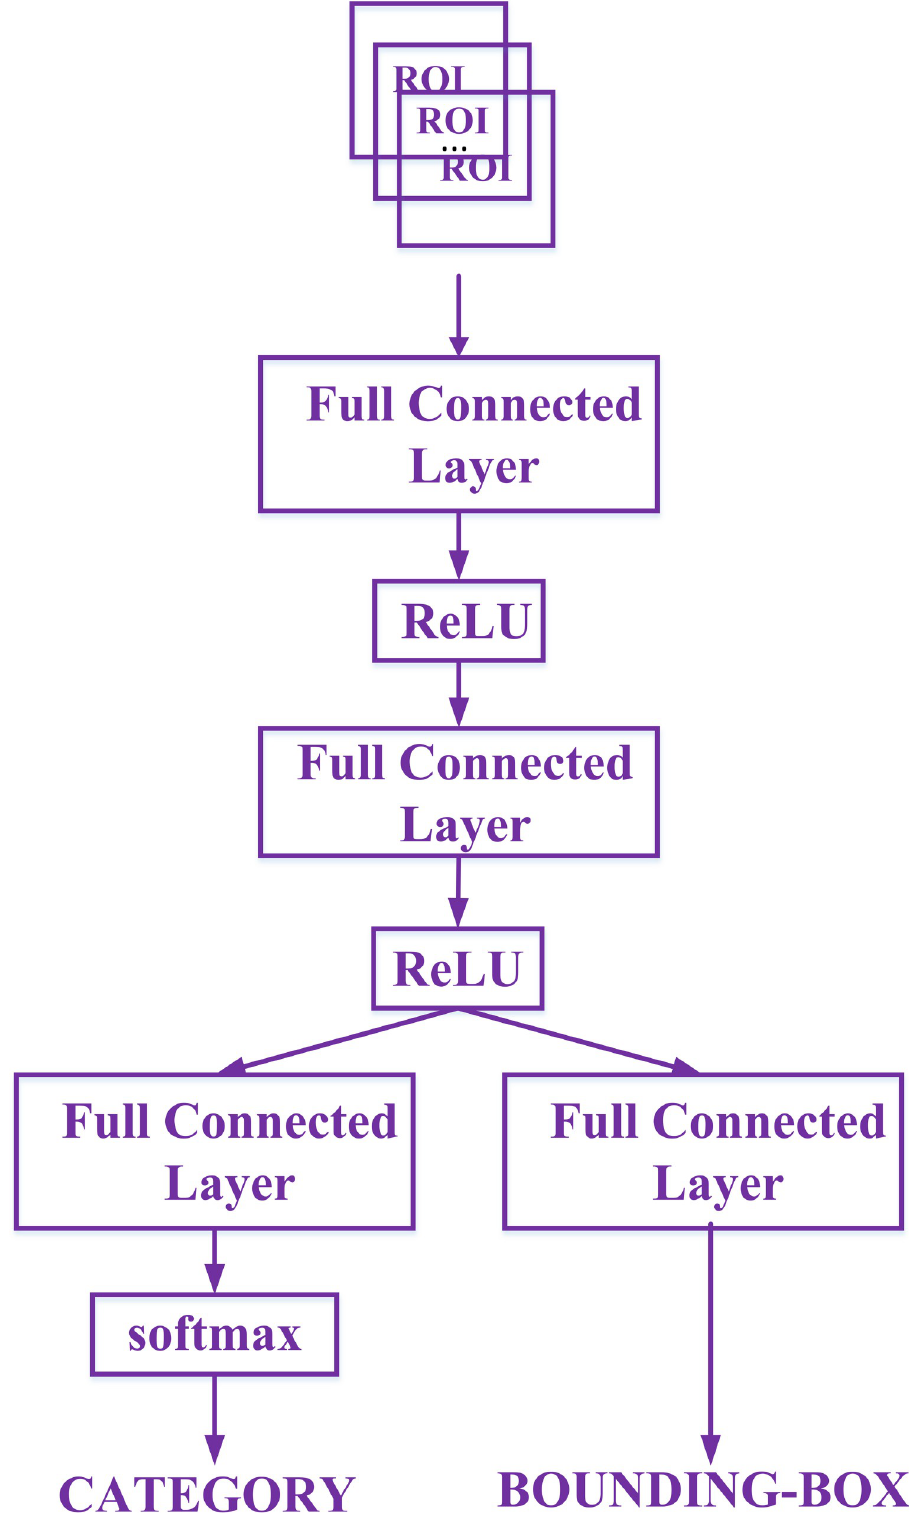
Fig 5. The bounding-box regression and category prediction process.